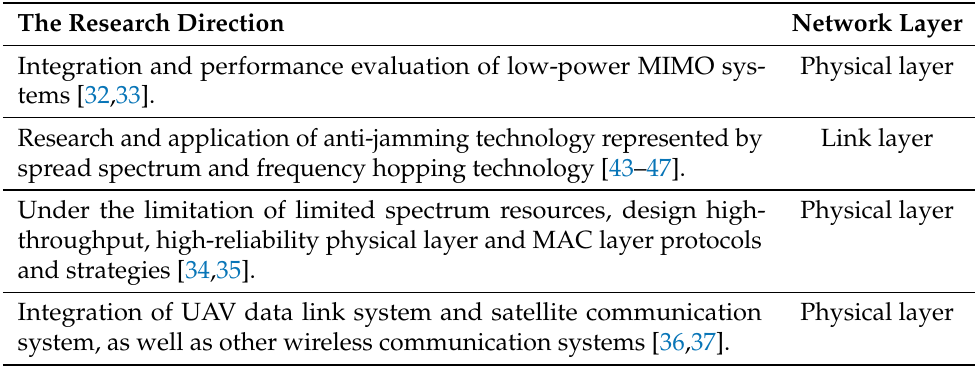
Table 4. Some typical anti-electromagnetic interference research